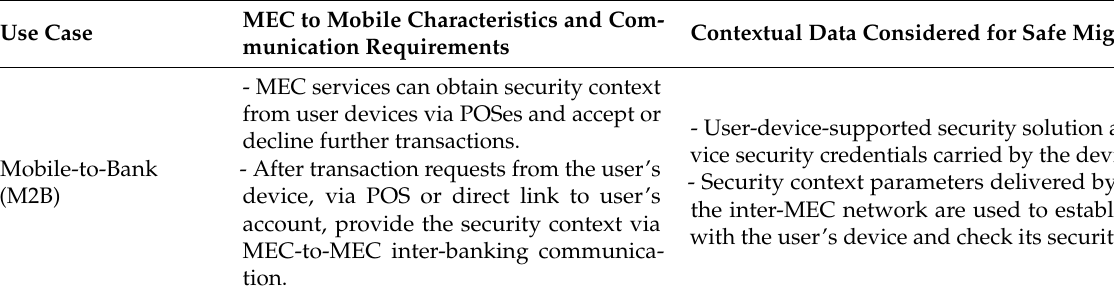
Table 6. Characteristics and requirements for MEC communication and data considered for